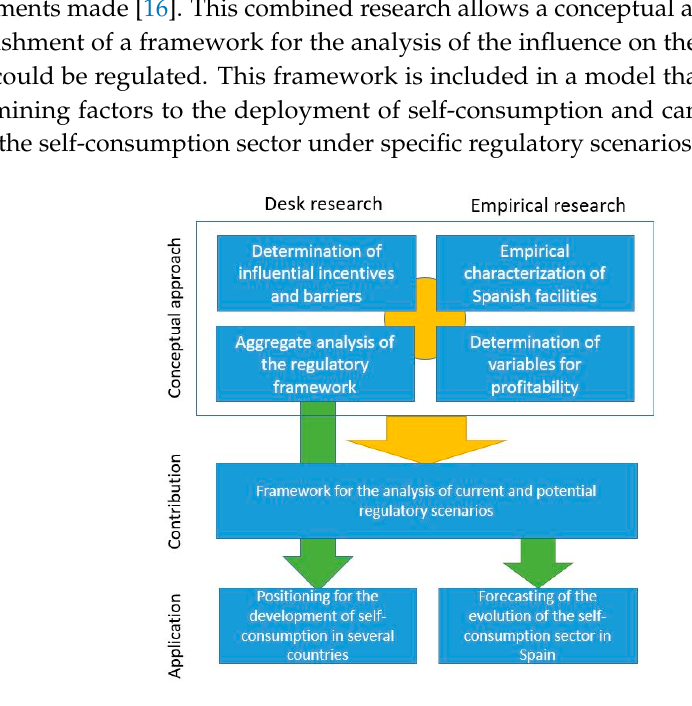
Figure 1. Flow chart depicting the applied methodology and results.